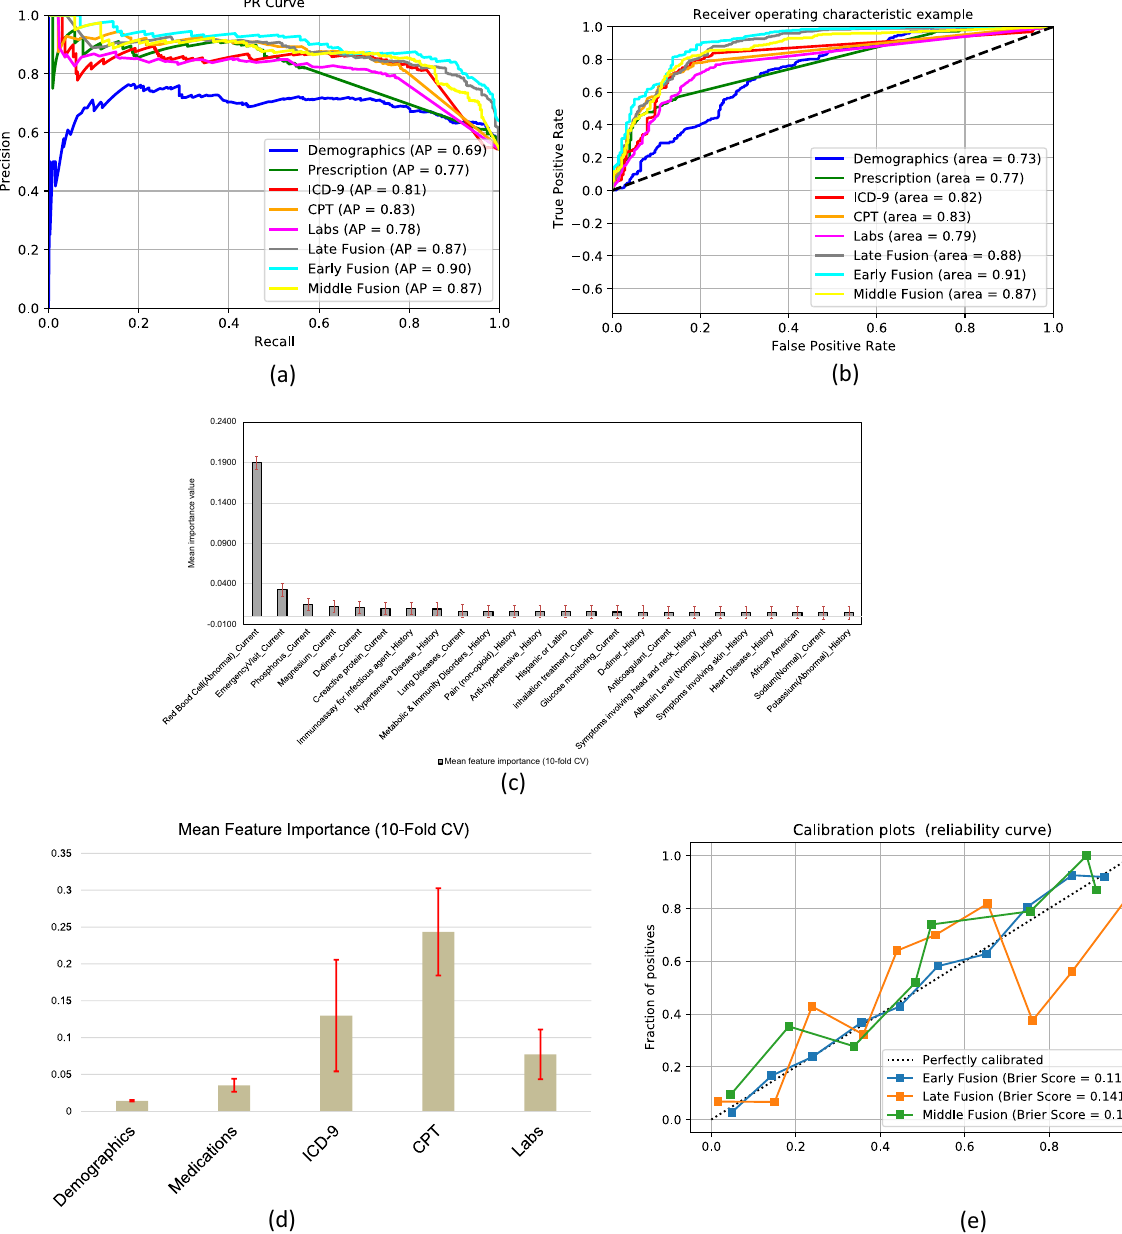
Fig. 2 Statistical analysis of the models. a PR (left) and ROC (right) curves for model distinguishing between self-isolation and hospitalization outcomes. Each colored line represents a separate model and the color scheme is consistent between PR and ROC curves. Feature importance from ( b ) early fusion — shows the importance of top 25 individual EMR data component, c late Fusion model — shows the importance of individual EMR data sources. The standard deviation bar (red) is generated via 10-fold cross-validation on the training data. d Calibration curve for early, late and middle fusion models along with Brier scores for each calibrated